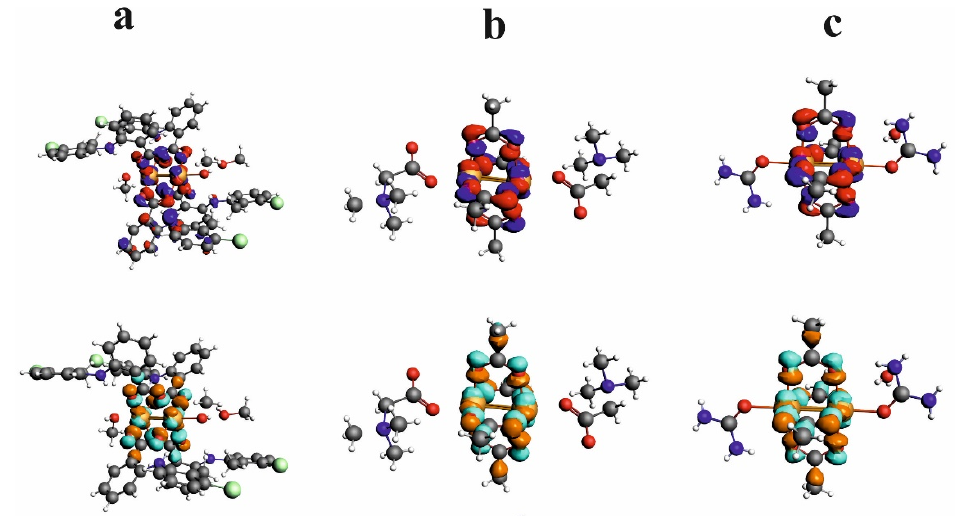
Figure 7. HOMO ( upper row ) and LUMO ( bottom row ) orbitals for [Cu II2 (Tolf) 4 (MeOH) 2 ] ∙ 2MeOH ( a ), QEBQIX ( b ), and ACURCU01 ( c ).